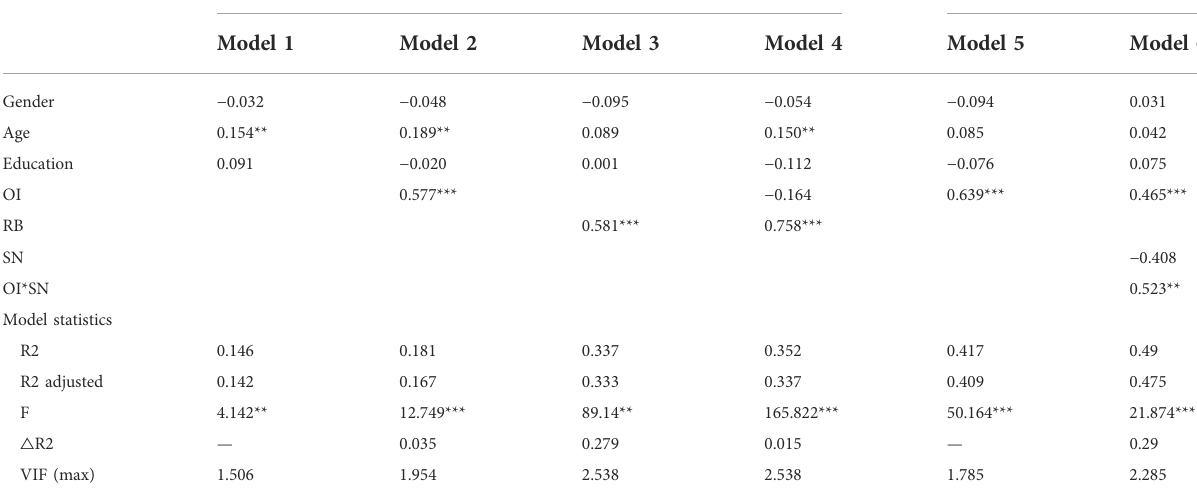
TABLE 4 Test of mediating